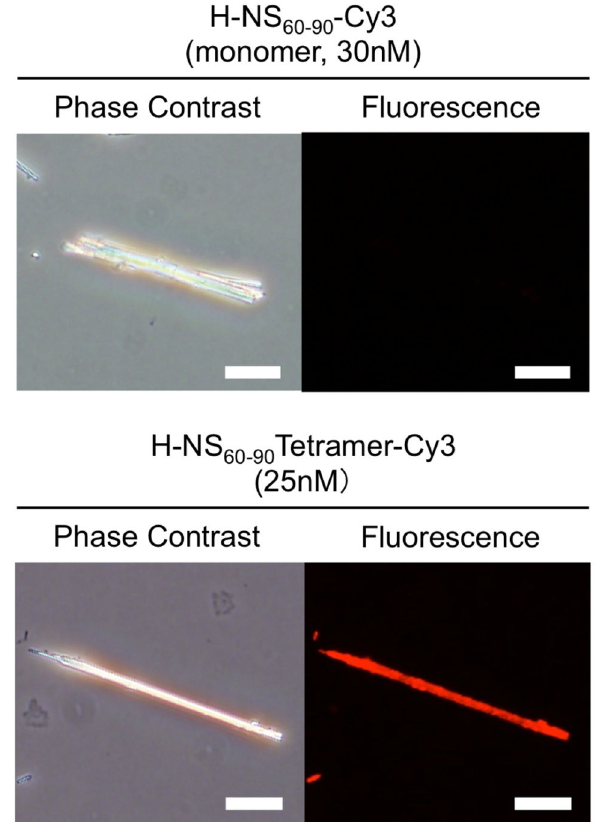
monomers and streptavidin-based tetramers of H- NS 60-90